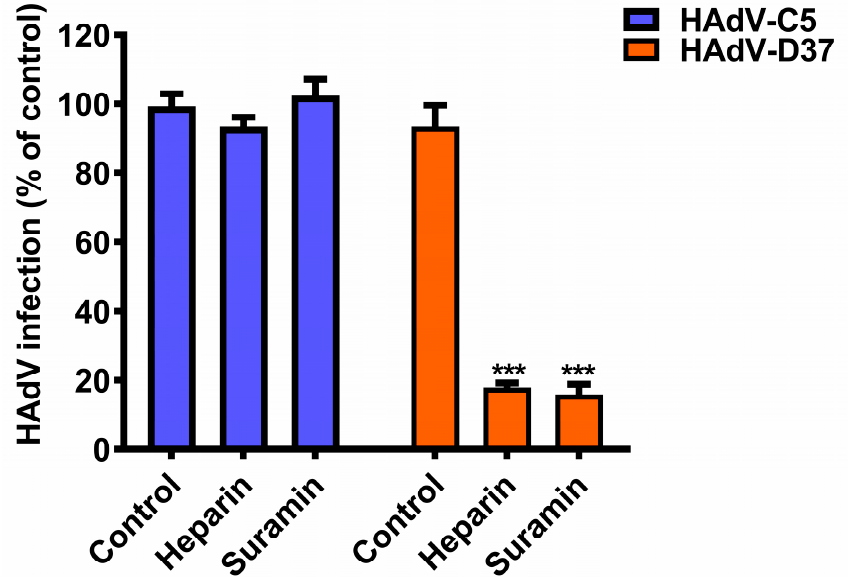
Figure 4. Antiviral activity of suramin is HAdV-type specific. HAdV-C5 and -D37 infection of human corneal (HCE) cells. Viruses were pre-incubated with heparin (0.4 mM) and suramin (1 mM). Virus infection of cells was quantified by immunofluorescence and the data is presented as % infection of untreated viruses. Error bars represent mean ± SEM. ns = not significant. *** P < 0.001 relative to control.